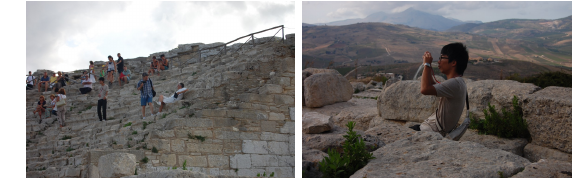
Figure 9: Some (not all) conference participants en- joyed mare and swimming pool bar.